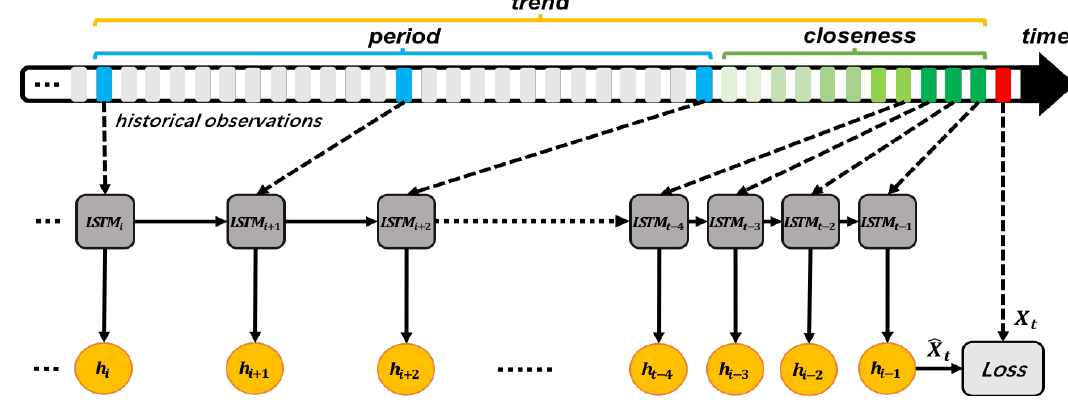
Figure 4. TD-LSTM networks architecture.